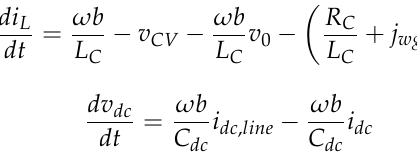
Figure 3. Rectifier DC current control